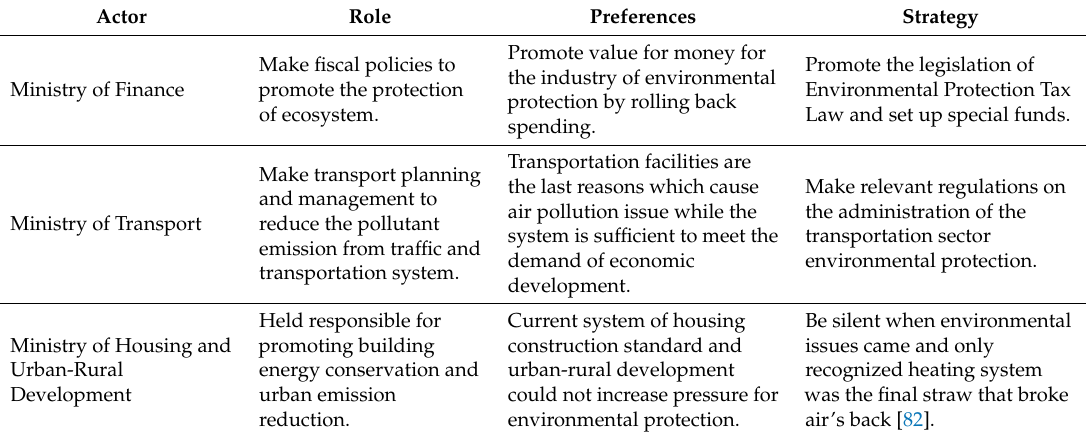
Table 4. Other influential policy actors in central